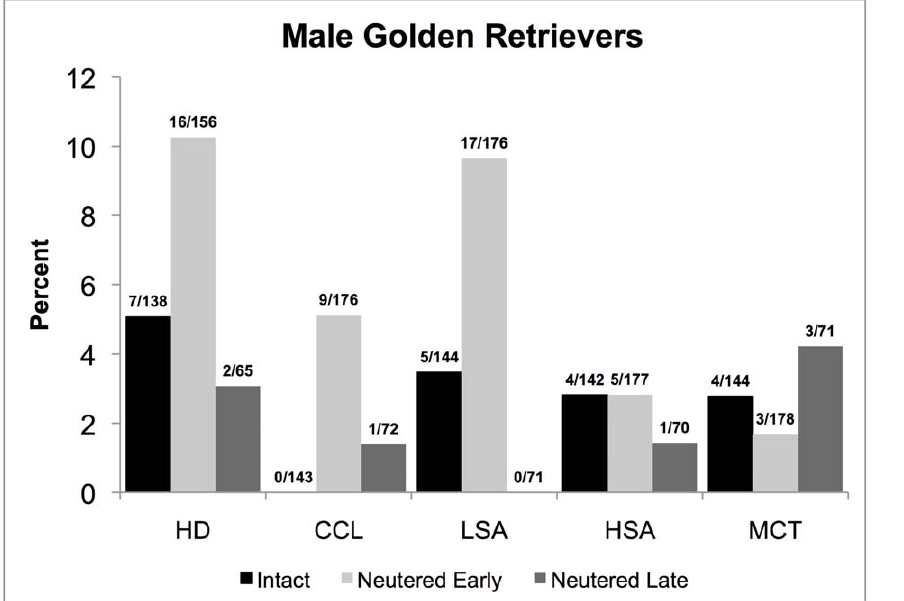
Figure 1. Percentages and number of cases over the total sample size for each neutering status group; intact and neutered early or late for male Golden Retrievers (1–8 years old) diagnosed with hip dysplasia (HD), cranial cruciate ligament tear (CCL), lymphosarcoma (LSA), hemangiosarcoma (HSA), and/or mast cell tumor (MCT) at the Veterinary Medical Teaching Hospital of the University of California, Davis, from 2000–2009. For HD and LSA, the differences between early-neutered and intact or late-neutered groups were statistically significant (K-M), as were differences for CCL between intact and early-neutered groups.